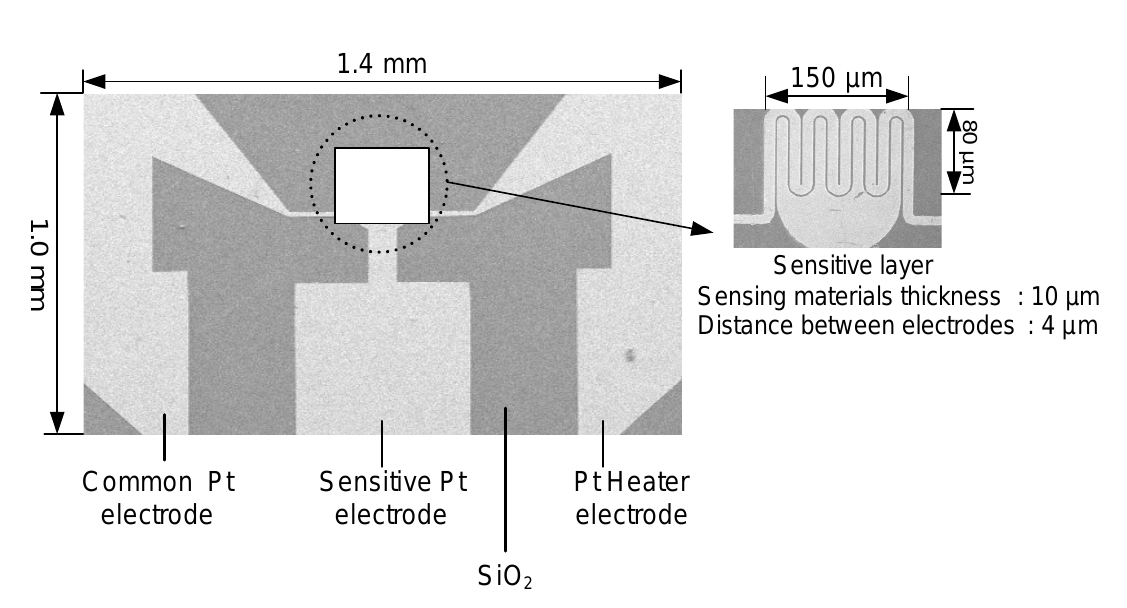
Figure 2. SEM photography of completed sensor substrate using the MEMS